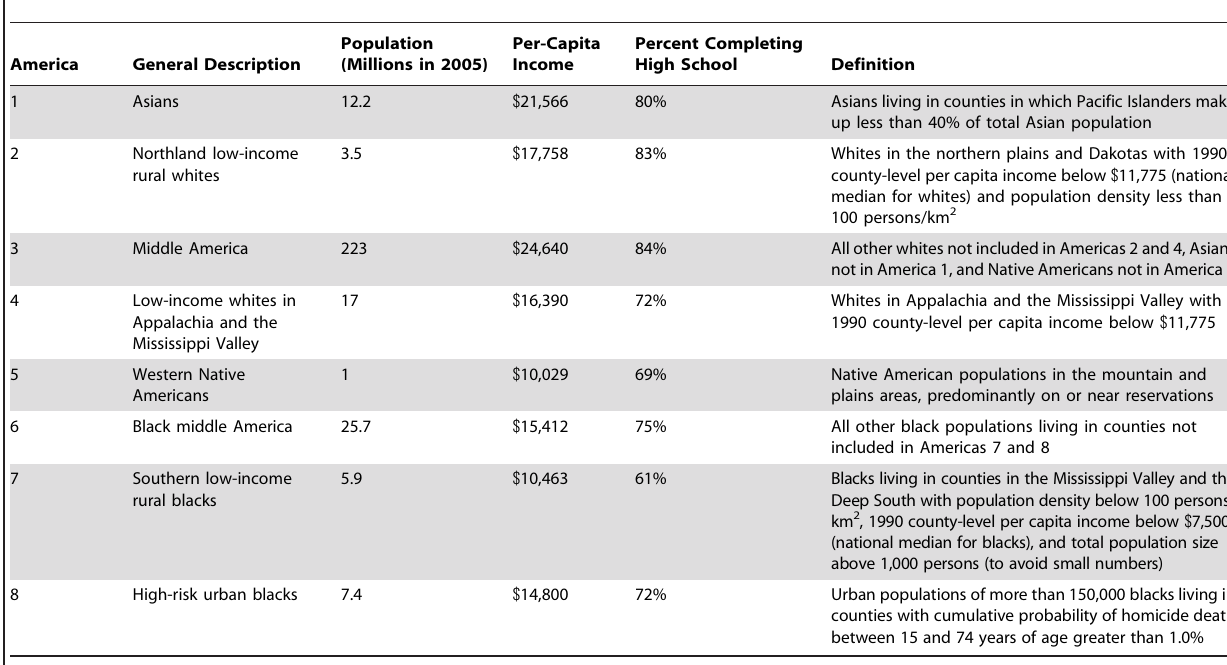
Table 1. Definitions and selected characteristics of the Eight Americas